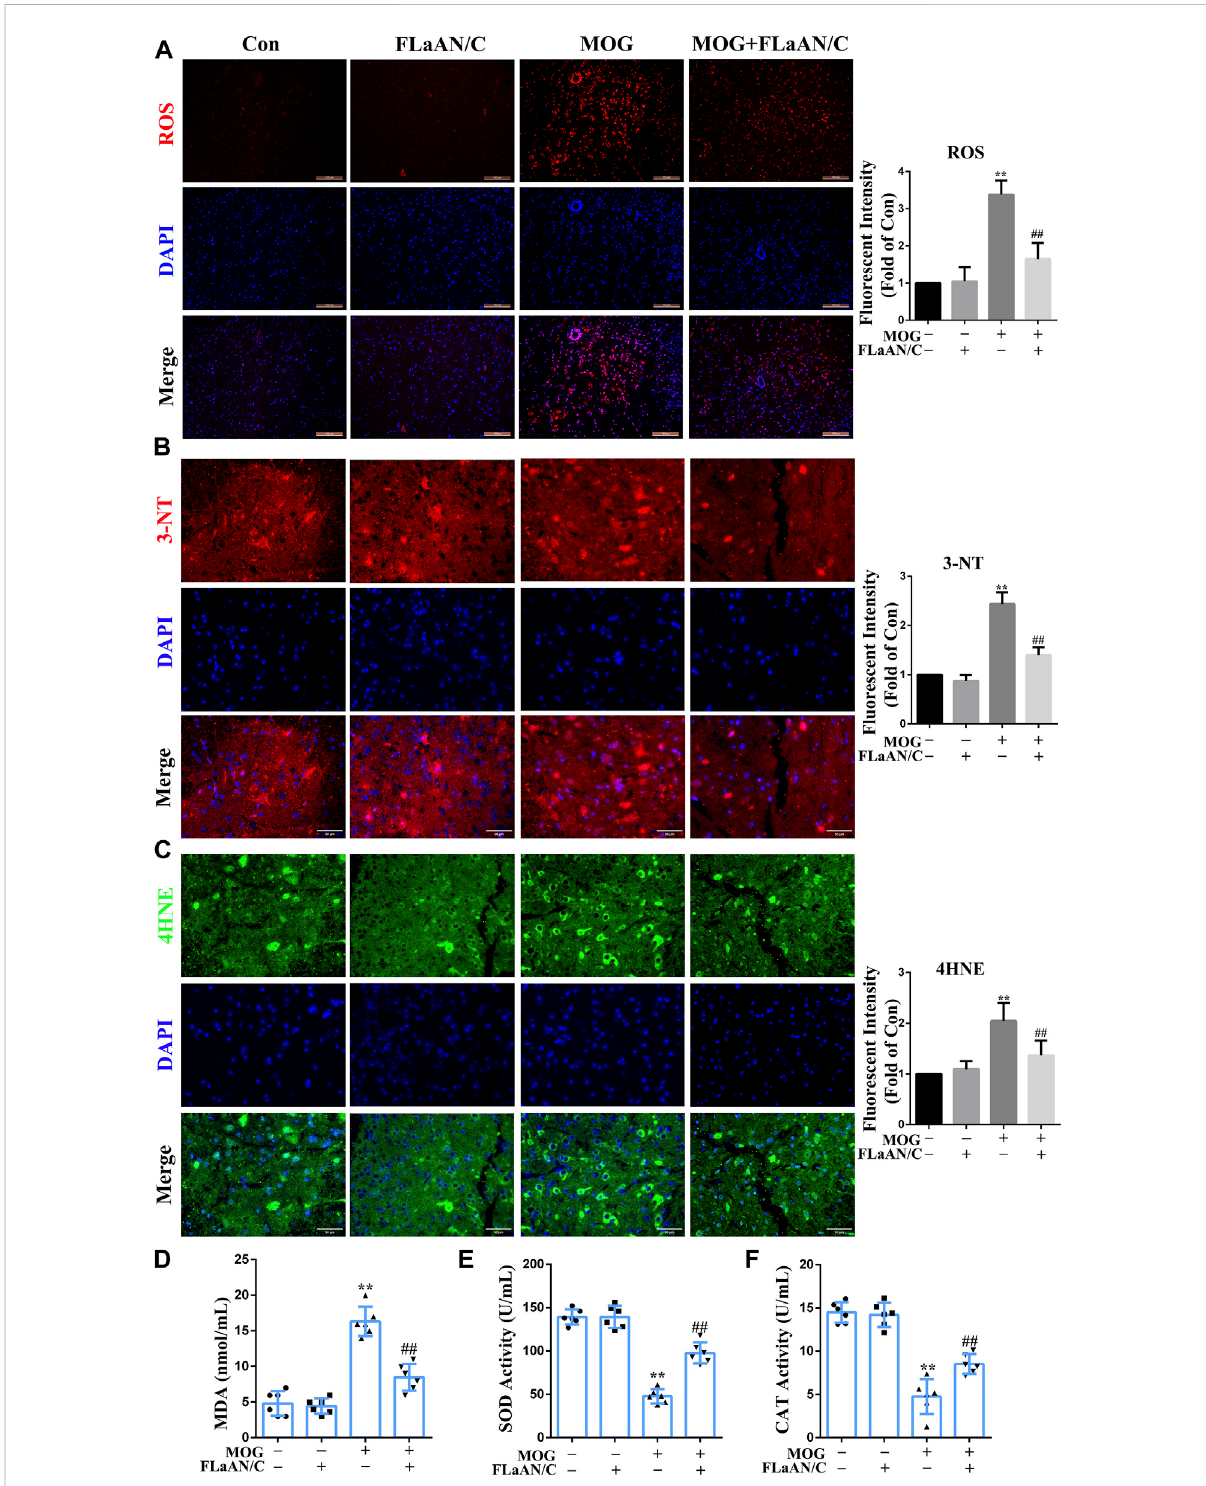
FIGURE 4 FLaAN/CalleviatedMOG-inducedoxidative stressinthespinal cordofEAEmice. (A) Abundanceofreactiveoxygenspecies(ROS)inspinalcord detected by DHE staining (scale bars: 100 μ m). (B – C) Representative immuno fl uorescent images of 3-NT (B) and 4HNE (C) in the spinal cord of all experimentalmice(scalebars:50 μ m). (D – F) Theactivitylevels ofMDA (D) ,SOD (E) andCAT (F) intheserumofeachgroupofmice. Paraf fi nsections ofspinalcordtissueusedforimmuno fl uorescencestaining.Dataareshownasmeans±SD(n=6pergroup).* p < 0.05,** p < 0.01,*** p < 0.001; # p < 0.05, ## p < 0.01, ### p < 0.001. * vs. Control group; # vs. MOG